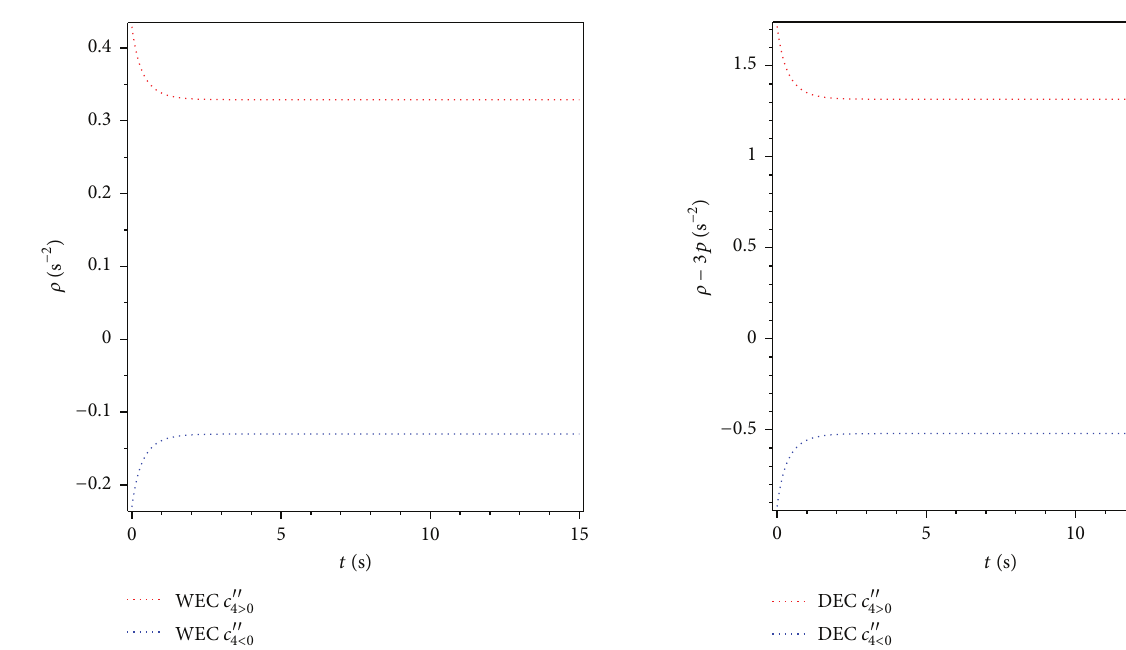
Figure 7: The evolution of the WEC for open model. Here the sign of the three constants 𝑐 󸀠 1 , 𝑐 󸀠 2 , and 𝑐 󸀠 3 has no effect on the evolution of WEC; however, 𝑐 󸀠 4 must have positive value to satisfy the WEC.